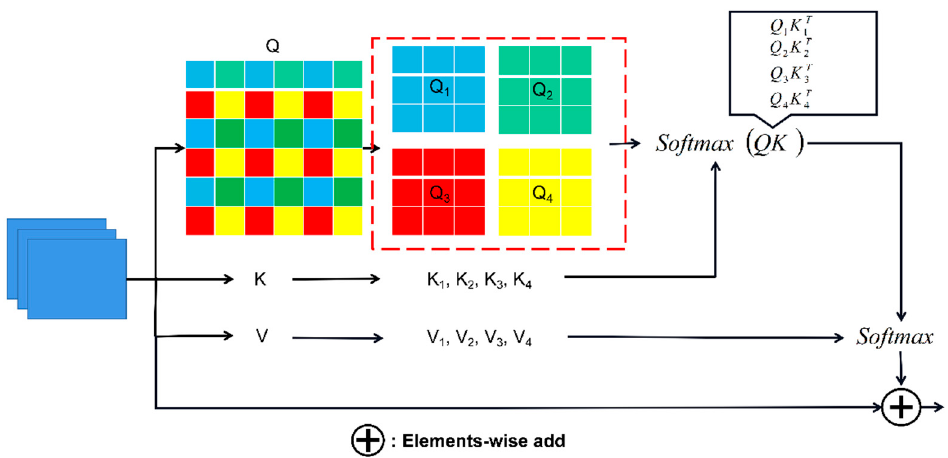
Figure 3. The structure diagram of the Focus Self-Attention Block. In the figure, the four small rectangles with different colors are the feature values of the Query feature interval. The features of Key and Value are treated in the same way as the Query features.